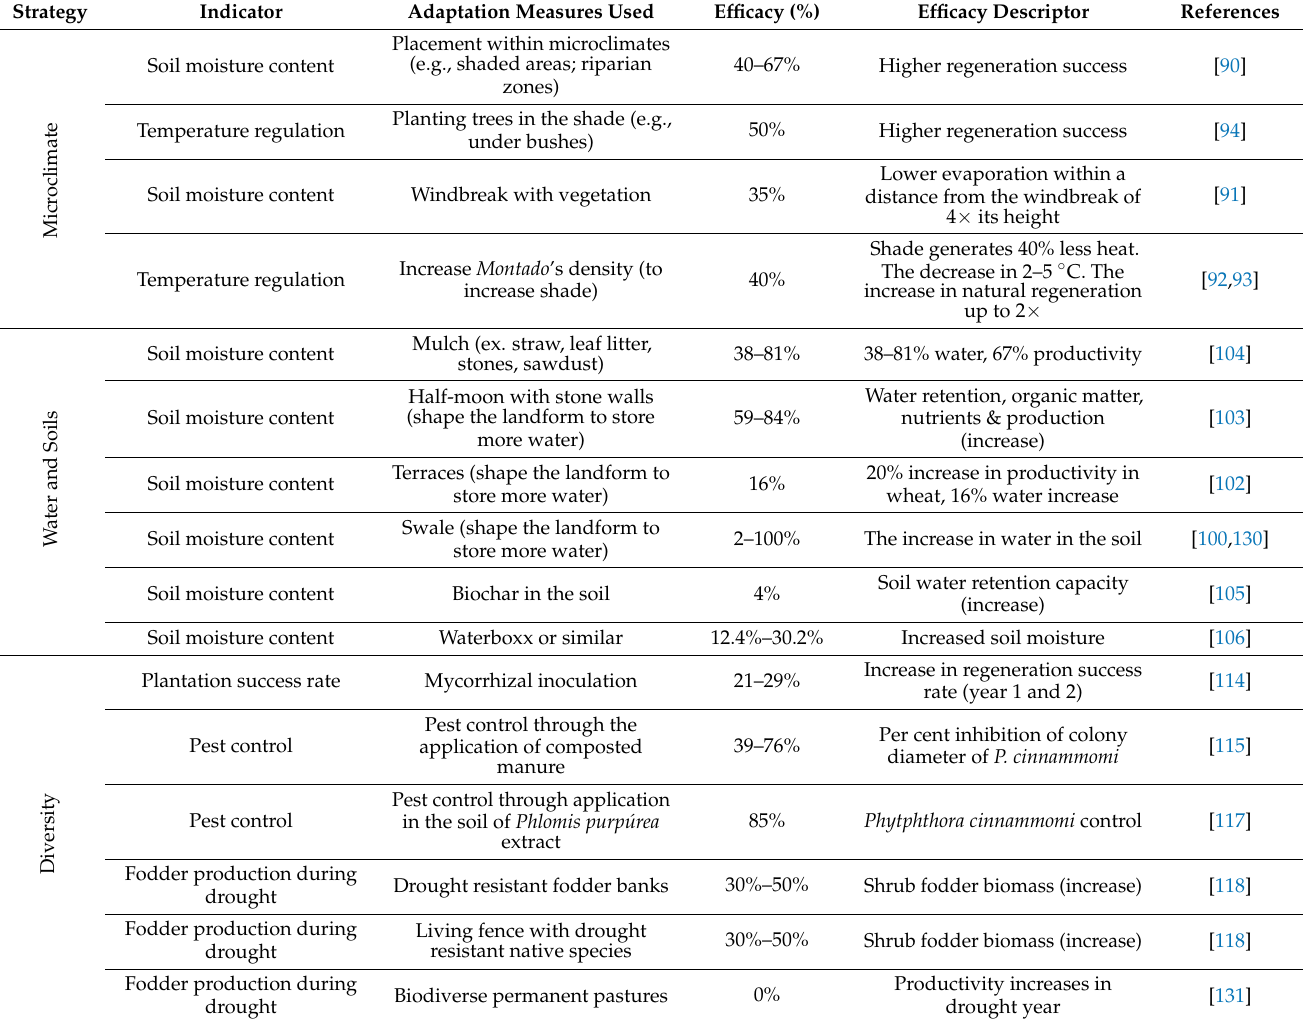
Table 3. Efficacy of Adaptation Measures. Columns include the Strategy and the Measure of adaptation, the Indicator of Success, a description of its efficacy, a value in percentage, according to each descriptor, and, in participatory workshops, a qualitative confidence value, attributed by the planners, according to the quality of the reference and the adequacy of the reference for the context under study and